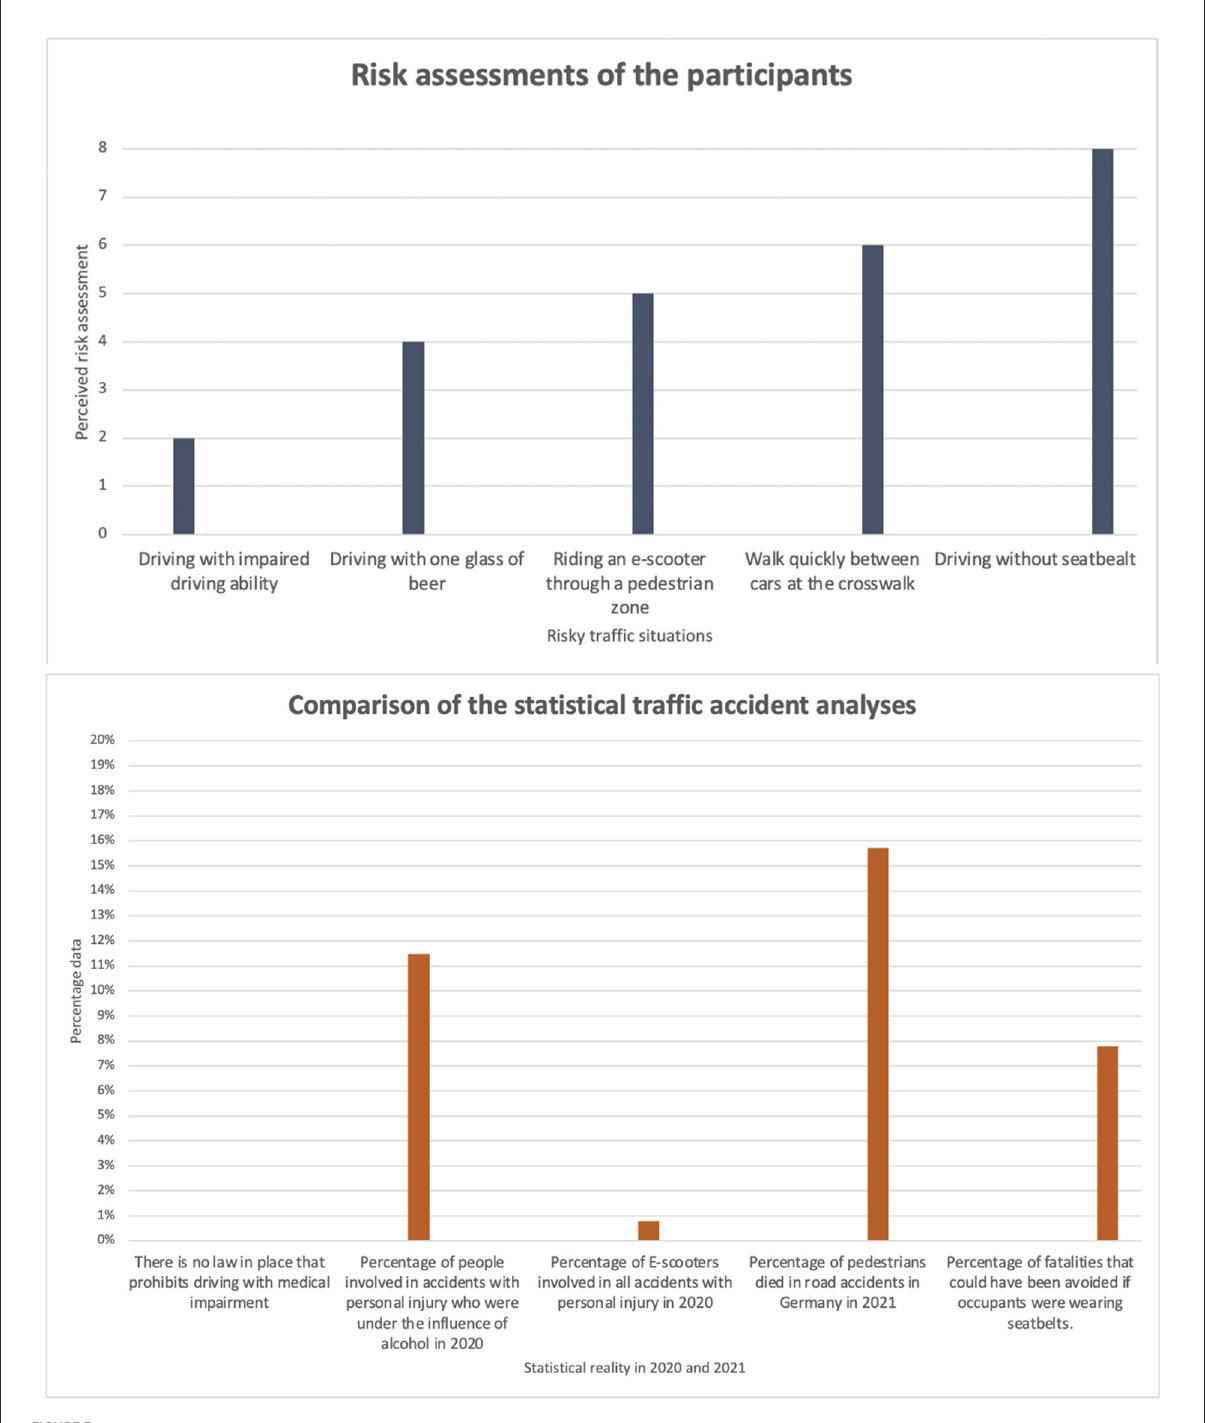
FIGURE5 Results of the risk assessment, comparison of personal assessments and statistical reality, (A) represents the assessment of the participants, (B) represents the actual dangerousness.